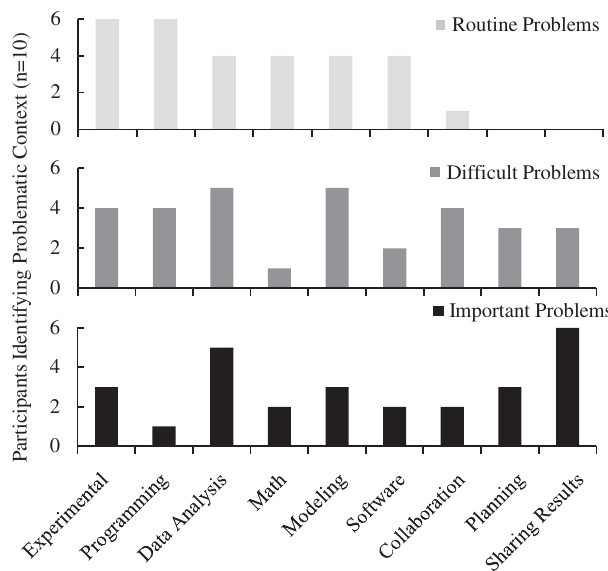
FIG. 3. Activities that result in routine, difficult, and important problems in Ph.D.-level